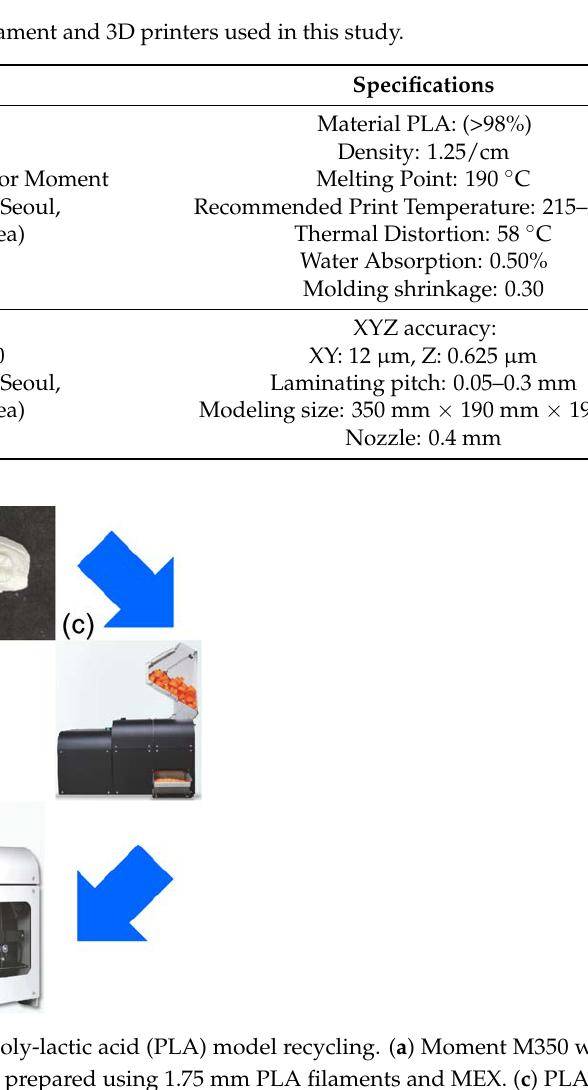
Figure 2. Provisional crown was placed on each model, and the marginal fit was measured using micro-computed tomography at the mesial center (M), distal center (D), buccal center (B), and pal- atal center (P) of the tooth. The accuracy of the model was verified based on Dunnett’s test using the bell curve in Excel (Social Survey Research Information Co., Ltd., Tokyo, Japan). Continuous data were expressed as mean ± standard deviation. Differences with a p -value < 0.05 were con- sidered statistically significant. 3. Results The results of this study are summarized in Table 2. For R, the accuracies at positions B, P, M, and D were 68 ± 16 µm, 66 ± 22 µm, 88 ± 13 µm, and 60 ± 31 µm, respectively. For R1, the accuracies at positions B, P, M, and D were 76 ± 34 µm, 86 ± 23 µm, 72 ± 27 µm, and 50 ± 12 µm, respectively. For R2, the accuracies at positions B, P, M, and D were 86 ± 36 µm, 216 ± 99 µm, 78 ± 44 µm, and 78 ± 48 µm, respectively. For R3, the accuracies at positions B, P, M, and D were 154 ± 94 µm, 336 ± 77 µm, 132 ± 49 µm, and 132 ± 41 µm, respectively; thus, the accuracies for R and R1 were lower than 120 µm, and those for R2 and R3 were greater than 120 µm at all measurement points if standard deviations were included.